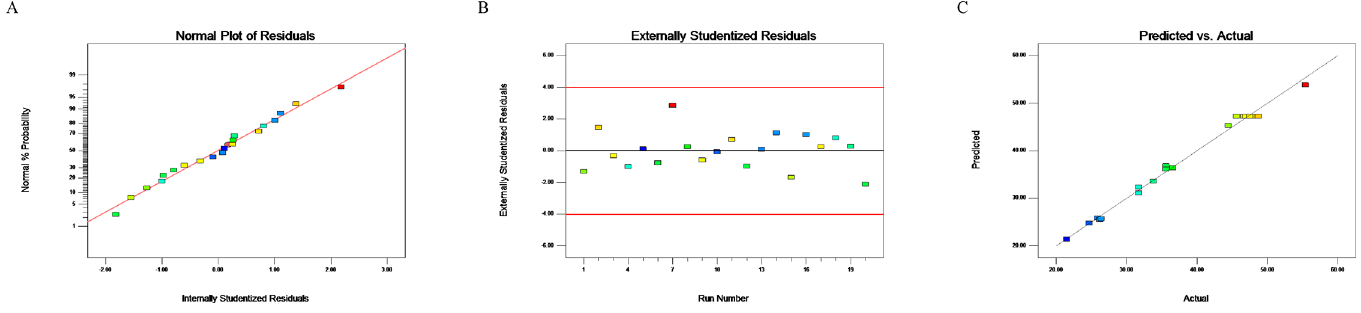
Fig 3. Residual diagnostic plots of the quadratic model. (A) The normaldistributionof residuals. (B) Residuals analysisof the experiment. (C) Comparisonbetweenthe experimental values and the predicted.